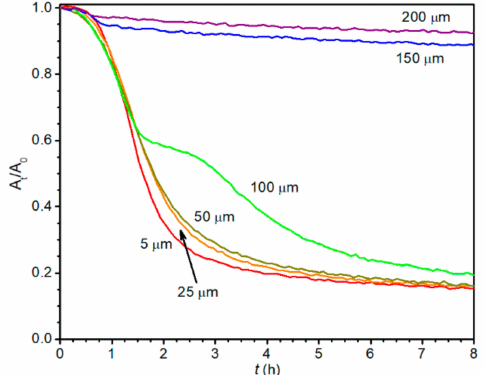
Figure 4. Development of ν a ( cis -C = C–H ) in time for coatings of Mn / S471 (0.03 wt.%). Labels refer to wet thickness of given